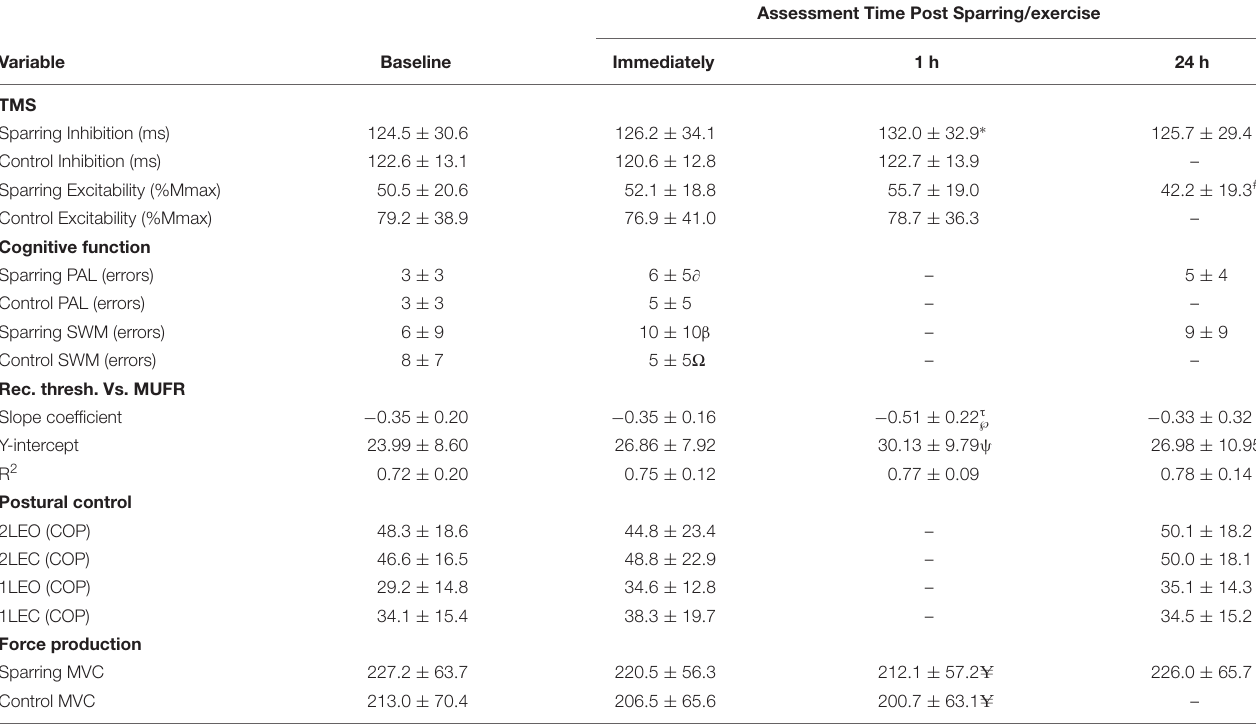
TABLE 2 | Mean ( ± SD ) values for each of the outcome measures: corticomotor inhibition (cortical silent period in ms) and corticospinal excitability (MEP amplitude normalized to femoral nerve M-wave, %Mmax), paired associate learning (PAL errors), spatial working memory (SWM errors), dEMG (rec. thresh. Vs. MUFR) and postural control (center of pressure for each condition) measured at each time